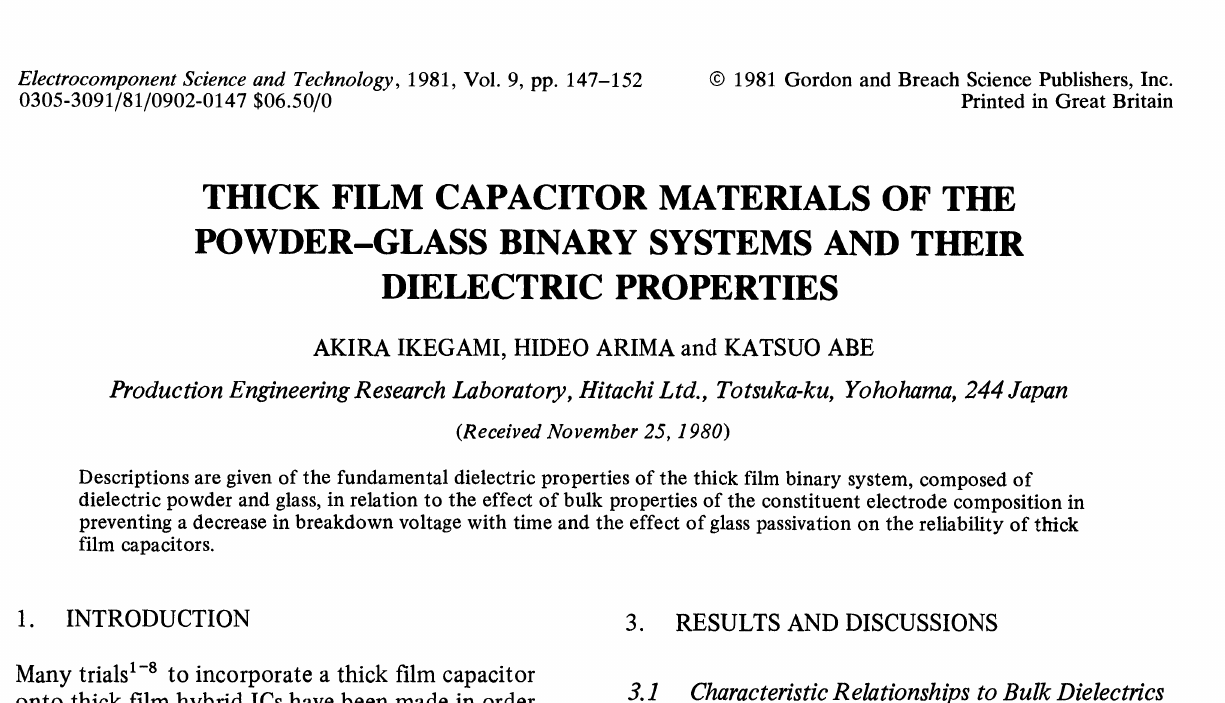
shows the dielectric constant (e) of thick film capacitor materials composed of BaTiO3 family dielectrics and glass as a function of the e of the raw dielectrics referring to 10 wt% glass content. The e of the binary system increases with increasing the e of the dielectrics. However, a strong trend to saturate is observed when a dielectric with e more than 3000 is used as a constituent. The major reason for the saturation is the depression of the e peak at the Curie point caused by the partial reaction between constituents and the dielectric degradation undergone during the grinding process. The e of this binary system is affected by the kind of binder glass, additives, electrode used and firing